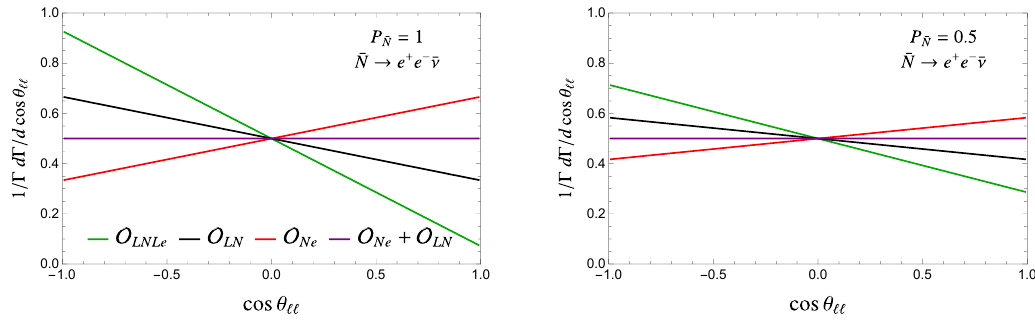
Figure 4 . cos θ ‘‘ distributions for P ¯ = 1 (left panel) and P ¯ = 0 . 5 (right panel), for four ¯ N decay N N operators: O LNLe (green), O LN (black), O Ne (red), and O Ne + O LN (purple). N is assumed to be a DF. Note the flat distribution for O Ne + O LN , as for a